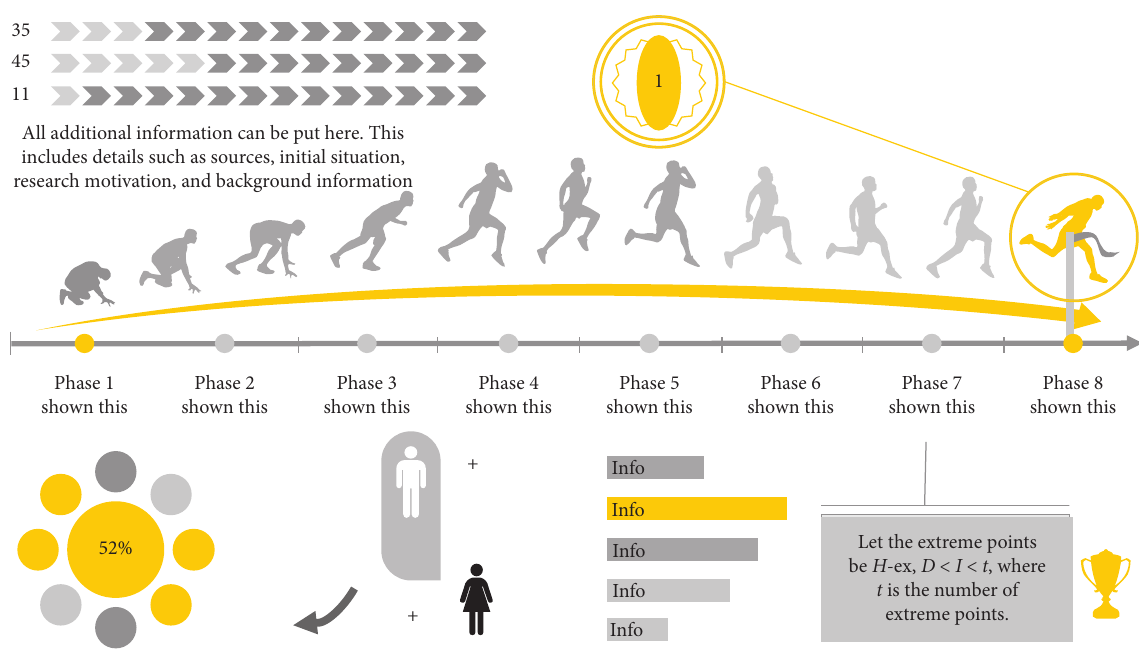
Figure 3: The flow chart of dynamically obtaining the smoothing